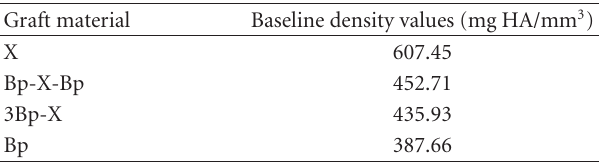
Table 1: Baseline density values for each grafting